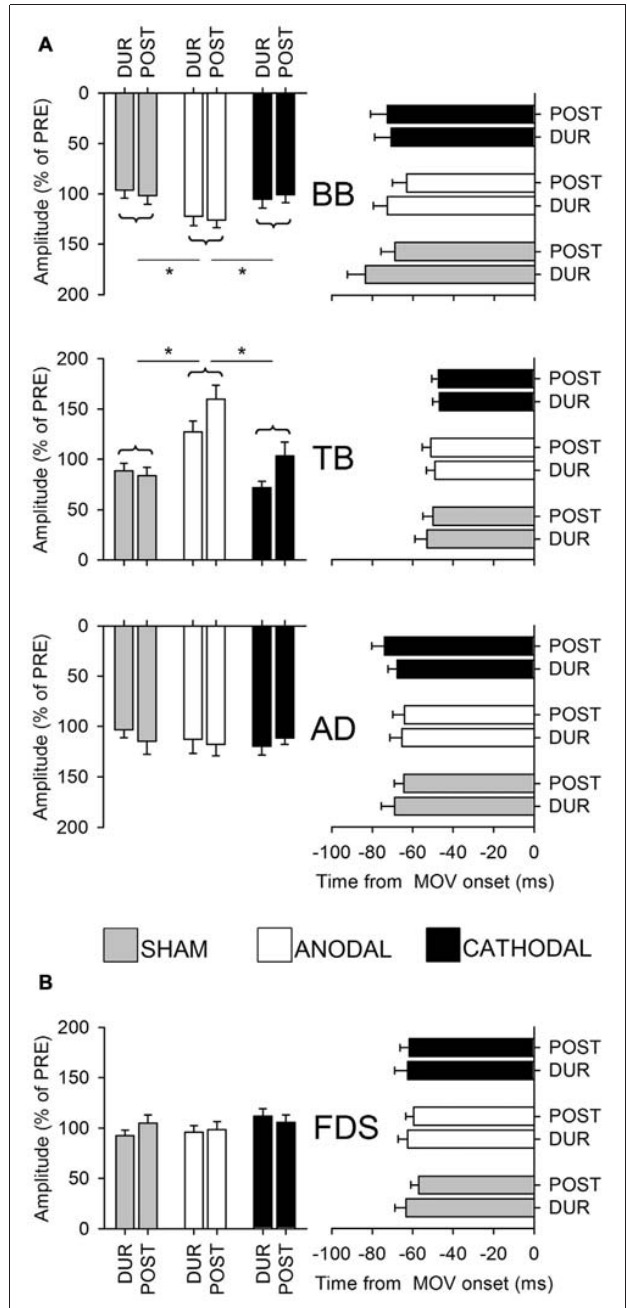
FIGURE 6 | Amplitude and latency of intra-limb APAs (A) and of voluntary recruitment of index-finger prime mover (B) . Postural muscles: BB, TB and AD, prime mover FDS. Data were collected from the whole population, in the last 5 min of 1 mA Transcranial Direct Current Stimulation (tDCS) application (DUR) and 20 min after its end (POST). Amplitude data are plotted on the left (expressed as percentage of the amplitude measured before tDCS, % of PRE), latencies referred to movement onset on the right (mean ± SE). Repeated measures stimulation × time ANOVA, and Tukey post hoc (see asterisks), found a significant increase in the amplitude of BB and TB APAs under ANODAL vs. CATHODAL and SHAM stimulation, while the APA in AD was unaffected. No effect of time or interaction was observed, thus ( Continued